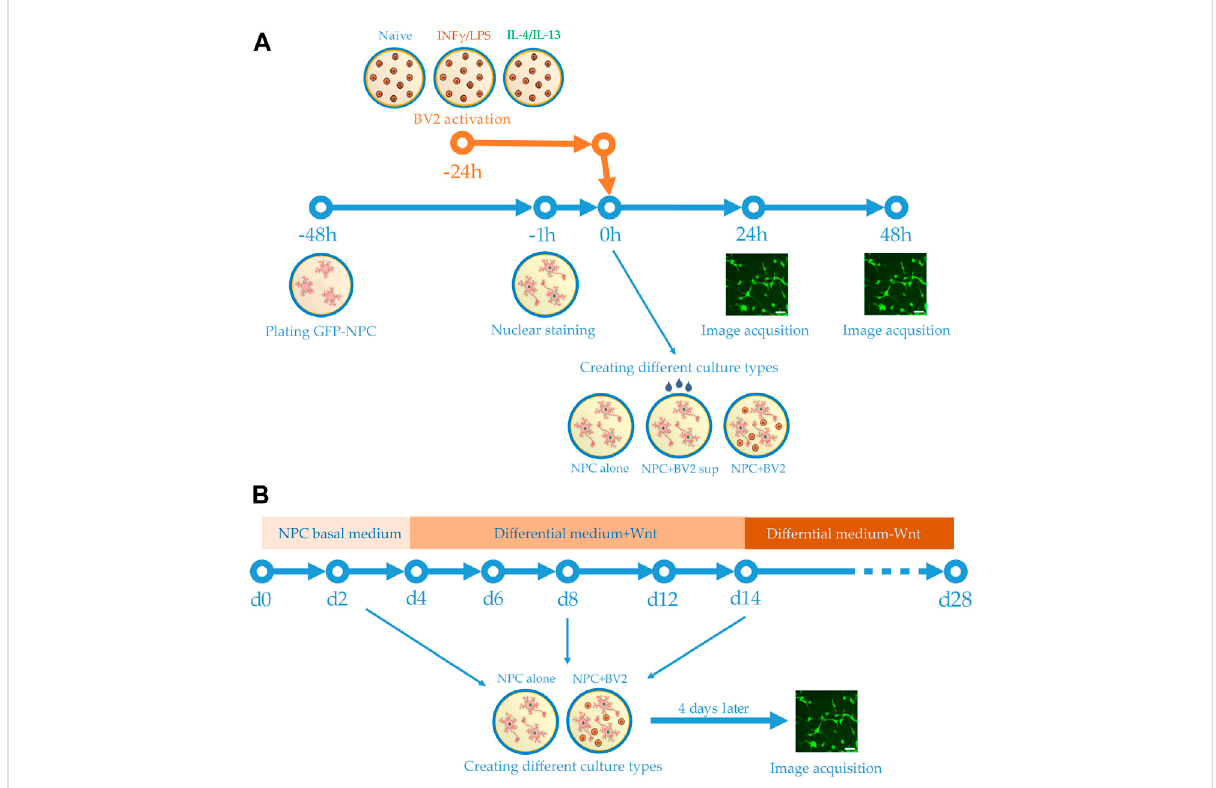
FIGURE 1 Schemesofexperimentaldesign. (A) HumanGFP-NPCs wereplated2 dayspriortotheexperiments.MeanwhileBV2cellswerestimulatedwith proin fl ammatory agents or anti-in fl ammatory cytokines. One hour before the experiments, the nuclei of GFP-NPCs were stained. GFP-NPCs were exposedtomicroglia-conditionedmedia(sup)orco-culturedwithmicroglia.GFP-NPCsaloneservedascontrol.ImageswereacquiredusingHCSat 0, 24, and 48 h. (B) Schematic representation ofthe differentiation protocol. Human NPCs were cultured inNPC basal medium for 4days, then further cultured for an additional 10 days in differentiation media. After 2 weeks, the Wnt was omitted from the complemented media. Co-cultures were assembled on days 2, 8, and 14; immuno fl uorescence staining and image acquisition were performed after 4 days of co-culturing (on days 6, 12, and